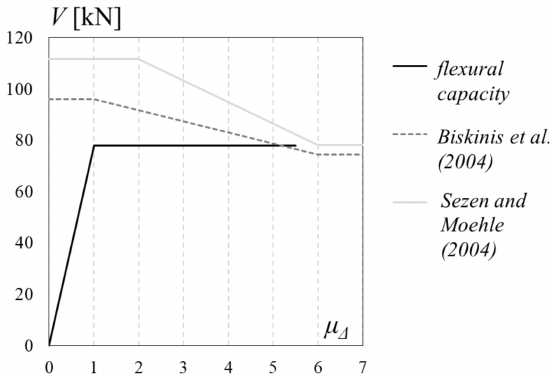
Figure 11. Theoretical capacity assessment.